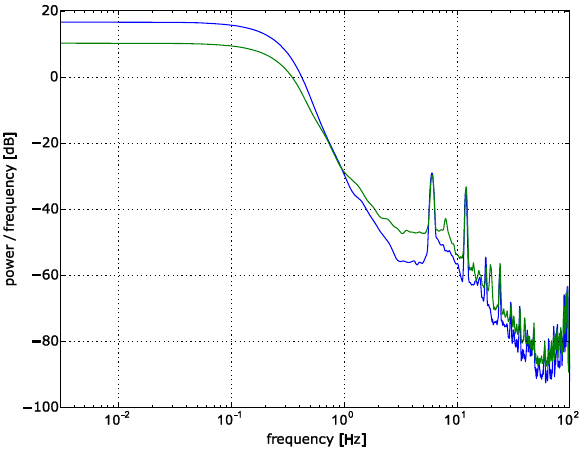
Figure 13. Power spectral density of the roll angle – Welch approach. Flight lines with stabilization – green, flight lines without stabilization – blue. Flight #1.